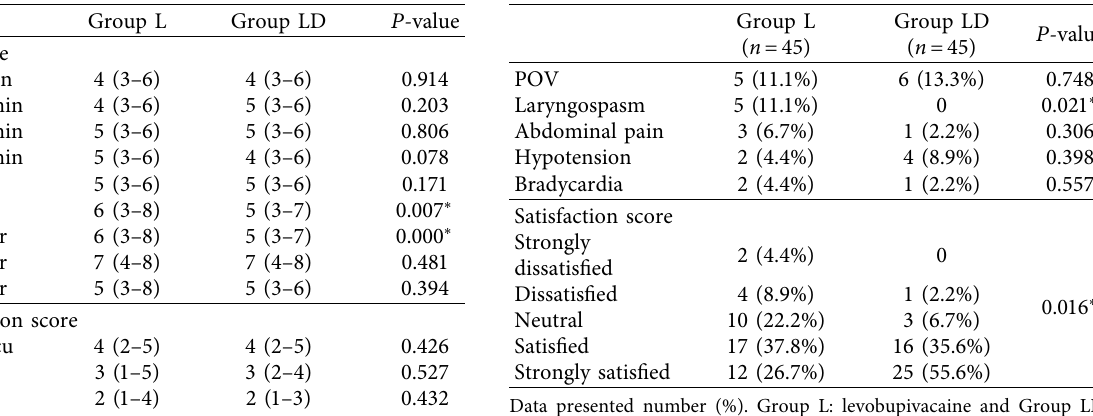
Table 3: Postoperative CHEOPS and ramsay sedation score. Table 4: Postoperative side effects and likert